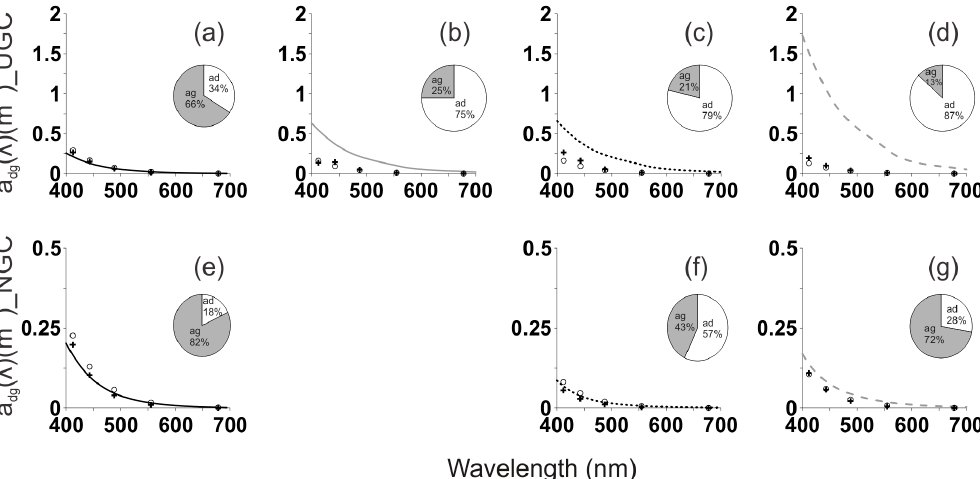
Figure 9. Average spectra of the absorption coefficient of dissolved and detrital matter ( a dg ( λ )) calculated for each cruise in the UGC ( a – d ) and NGC ( e – g ). The pie chart inside diagrams represents the percentage contribution of detritus ( a d ) and chromophoric dissolved organic material (CDOM) ( a g ) to a dg ( λ ). Open circles represent GSM a dg ( λ ) values and black crosses represent GIOP a dg ( λ ) values. Note: The August 2012 cruise was represented by a single station and was not included in the figure.